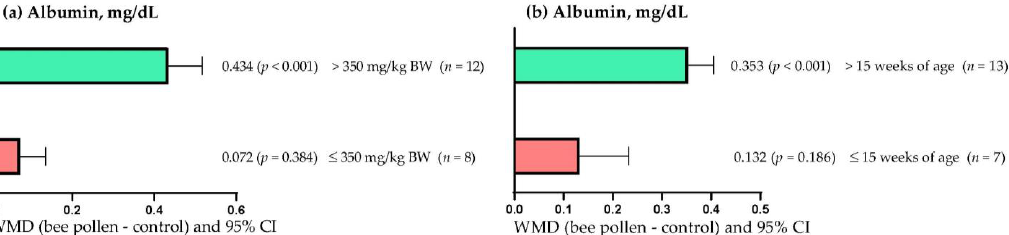
Figure 3. Subgroup analysis (subgroups = bee pollen dose (mg/kg of BW), and age of rabbits (weeks)) of the effect of bee pollen supplementation in rabbits, WMD = weighted mean differences between bee pollen treatments and control.